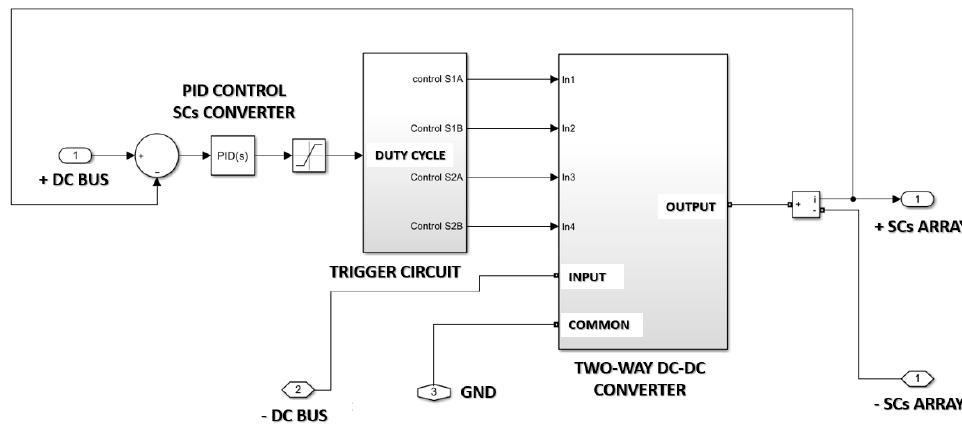
Figure 21. Two-way DC/DC converter with its PID current controller.